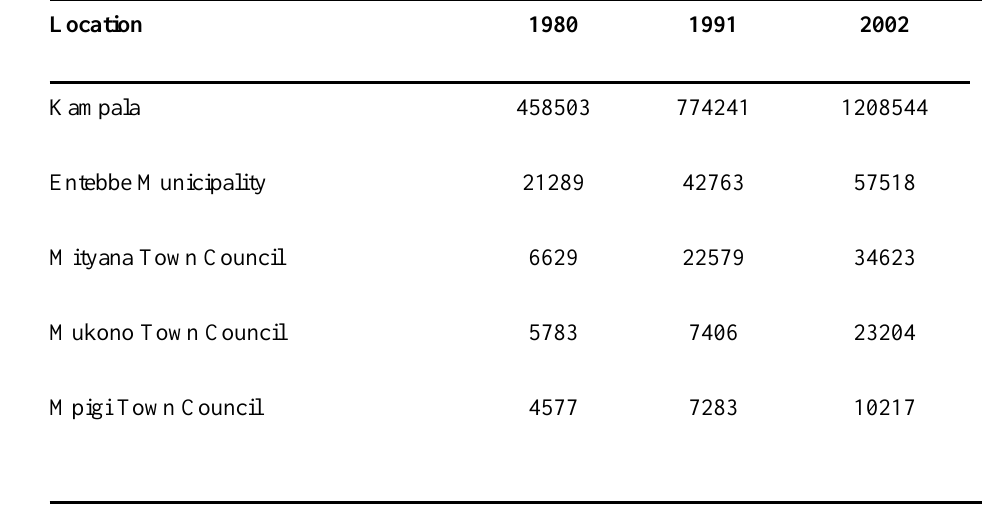
Table 1. Absolute urban populations in study area: 1980–2002. Table prepared by Nathan Vogt based on the Uganda Bureau of Statisitics (UBOS)